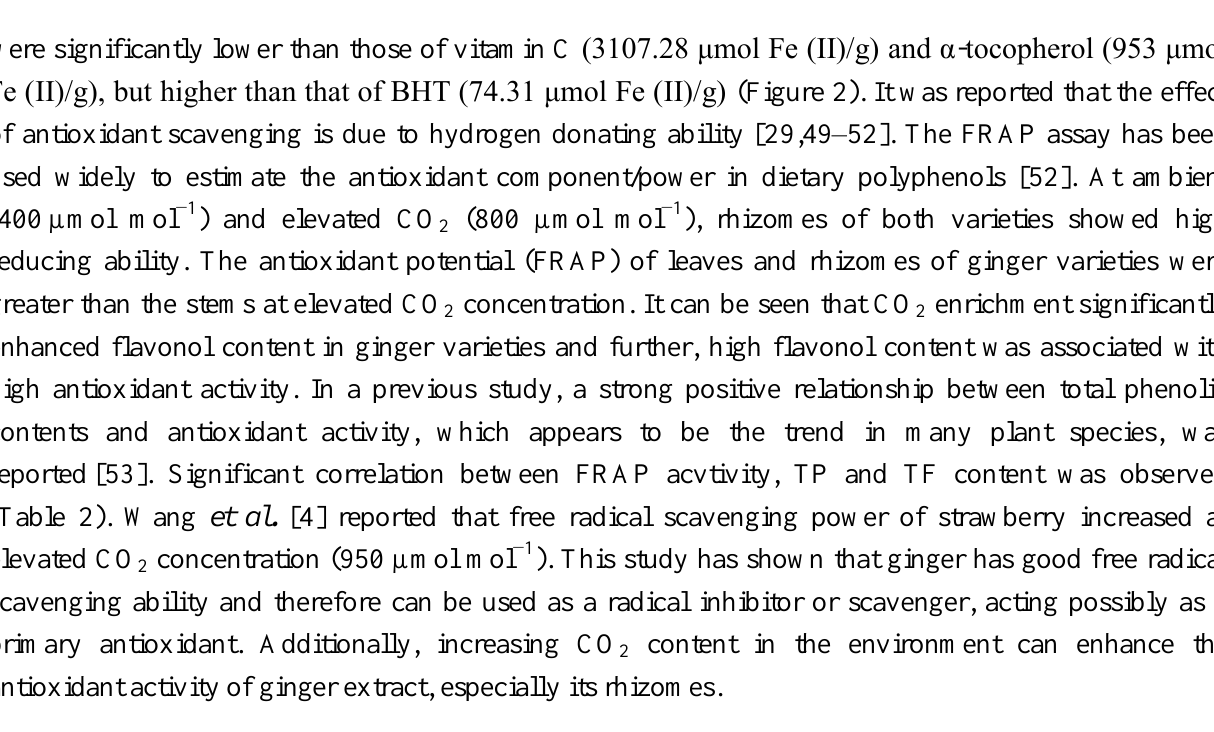
Table 6. Total antioxidant (FRAP) activity in different part of two varieties of Z. officinale .